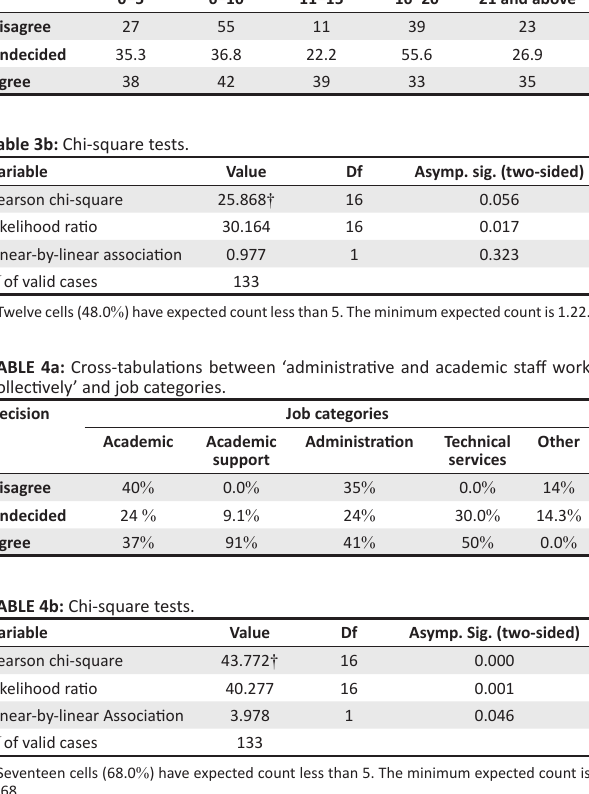
TABLE 3a: Cross-tabulations between ‘at my university, interventions of change are productive’ and tenure. Decision